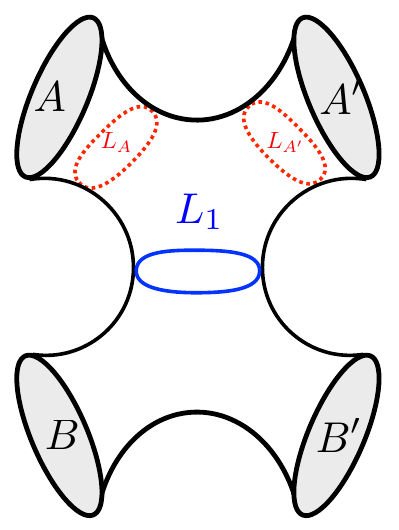
Figure 7 . Four boundary wormhole. The “areas” of the neck region L A , L A 0 , and L 1 are shown pictorially. As decoherence process evolves, L 1 shrinks to